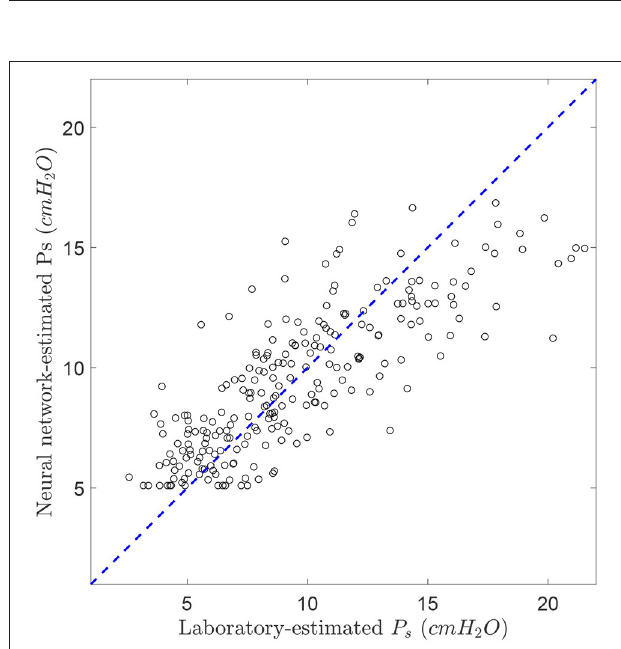
FIGURE 5 | Comparison between laboratory-estimated subglottal pressure and the corresponding estimates from the trained neural network (2-hidden layer, 4 neurons in each layer, and 7 voice features). R 2 = 0.65. The dashed line represents the theoretical 1:1 perfect